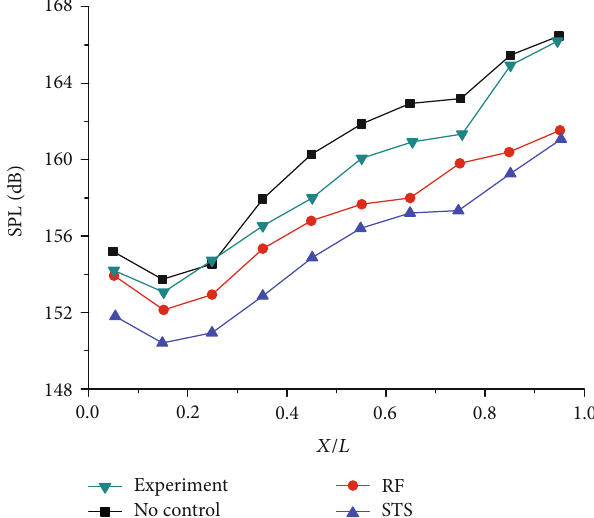
Figure 13: OASPLs for di ff erent